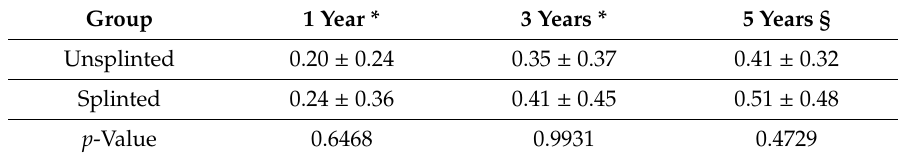
Table 4. Marginal bone loss.